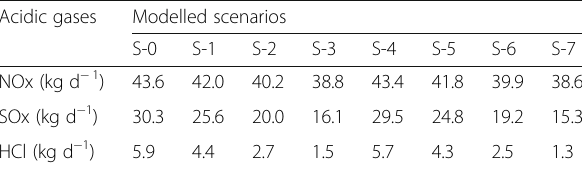
Table 7 Emission of heavy metal and organics to air in total